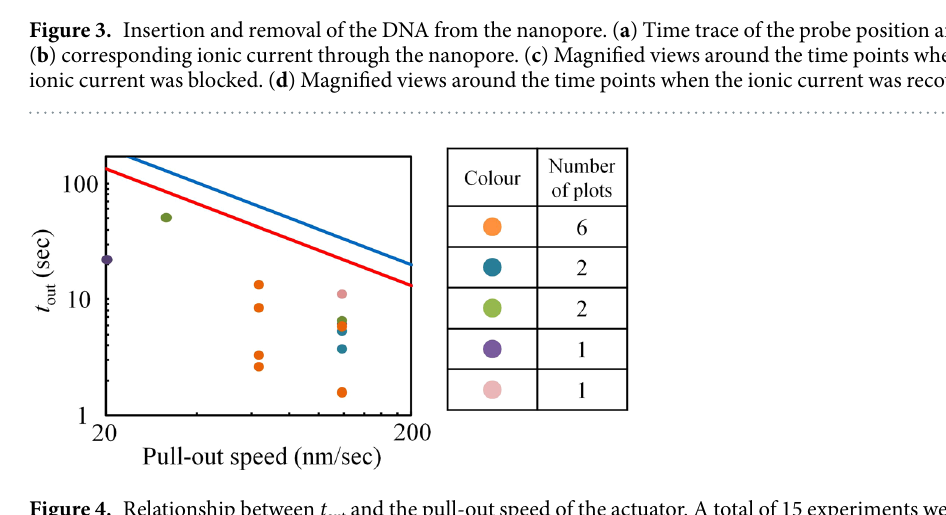
Figure 4. Relationship between t out and the pull-out speed of the actuator. A total of 15 experiments were performed and the results have been plotted. The circles plotted present the experimental data. The data acquired using the same nanopore chip are expressed using the same colour for the data points. The red and blue lines represent the calculated limits of t